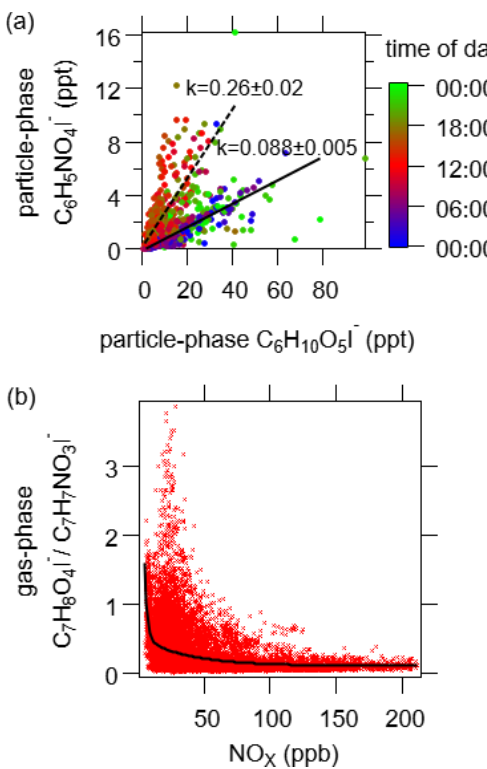
Figure 5. (a) Correlation between particle-phase C 6 H 5 NO 4 I − and C 6 H 10 O 5 I − . The data points are color-coded using the time of the day. Solid and dash lines represent the slopes during the nighttime and daytime, respectively. (b) Relative concentration of C 7 H 8 O 4 I − and C 7 H 7 NO 3 I − in the gas phase as a function of NO x concentra- tion. The black line is the fitted curve using a double exponential